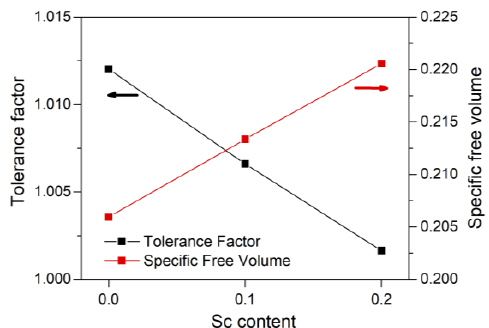
Figure 4. Goldschmidt tolerance factor and specific free volume of PBCO, PBCSc, and SP-PBCSc.